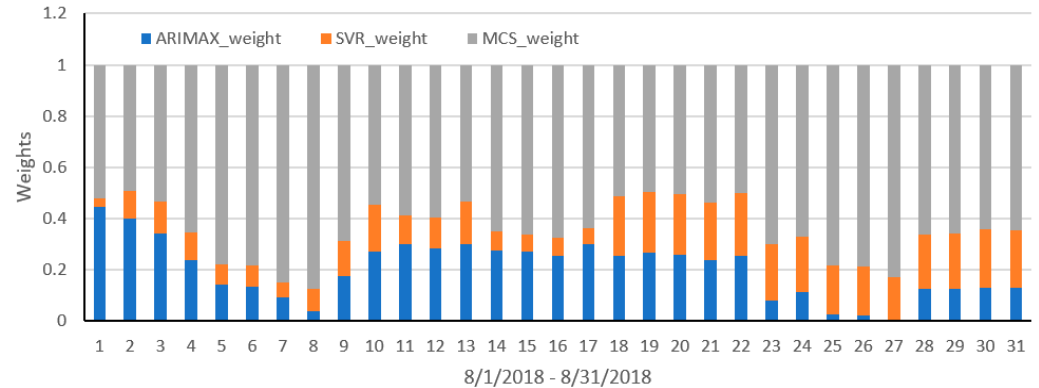
Table 3. Accuracy of single models for two months.